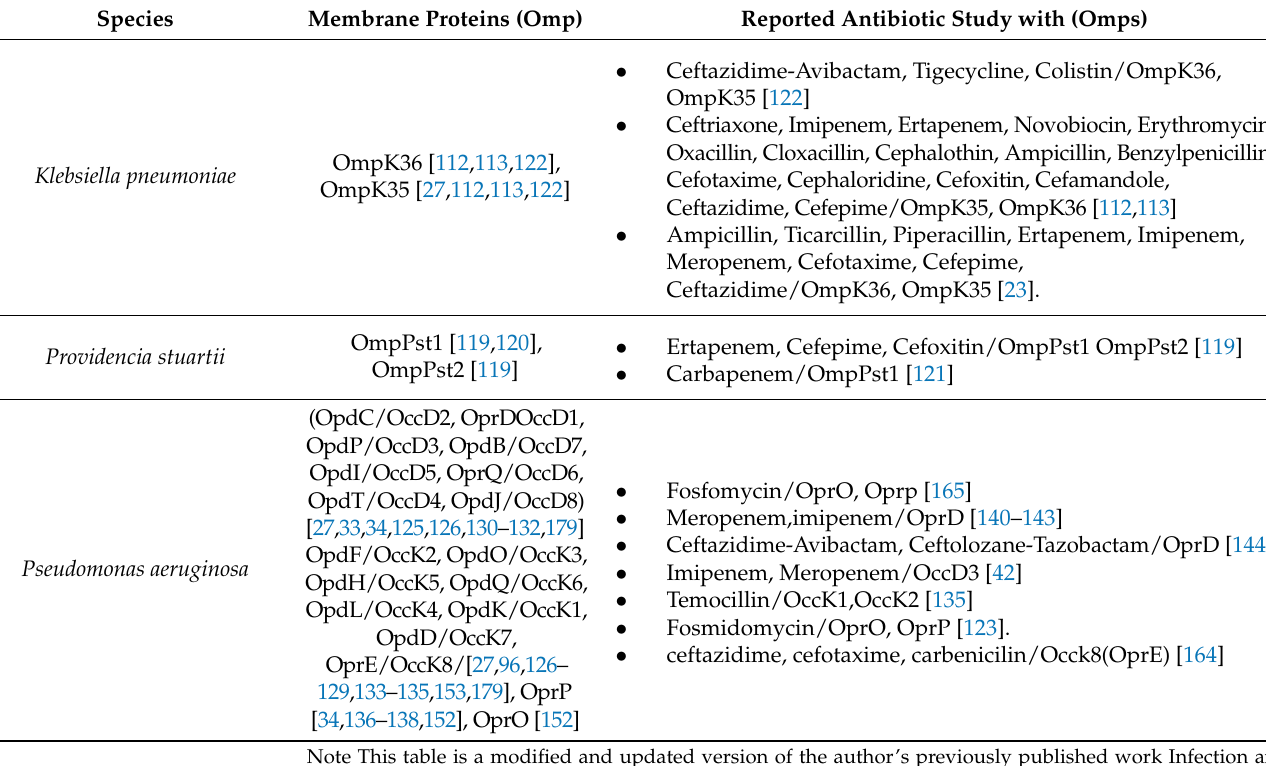
Table 3. Reported turnover rates molecules/second at a given concentration gradient for different outer membrane proteins (Omps) with different substrates. The values are approximate, and